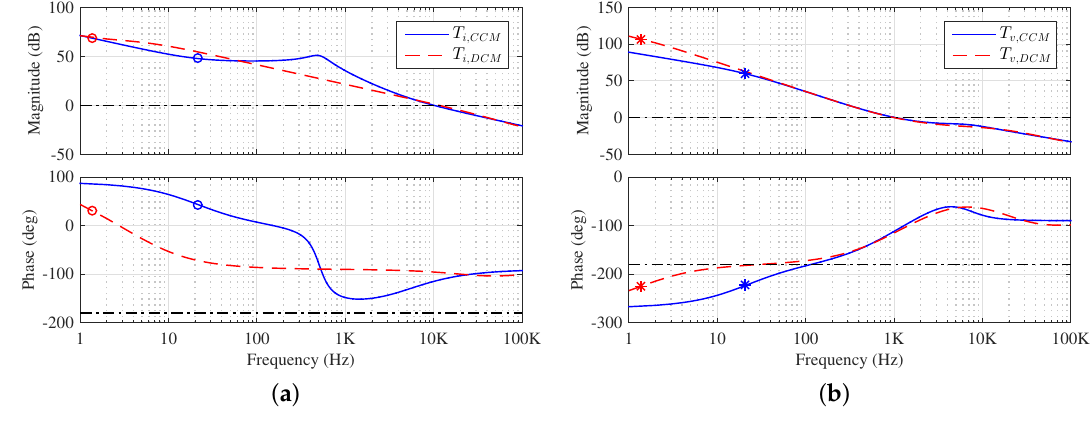
The RHP zero and pole